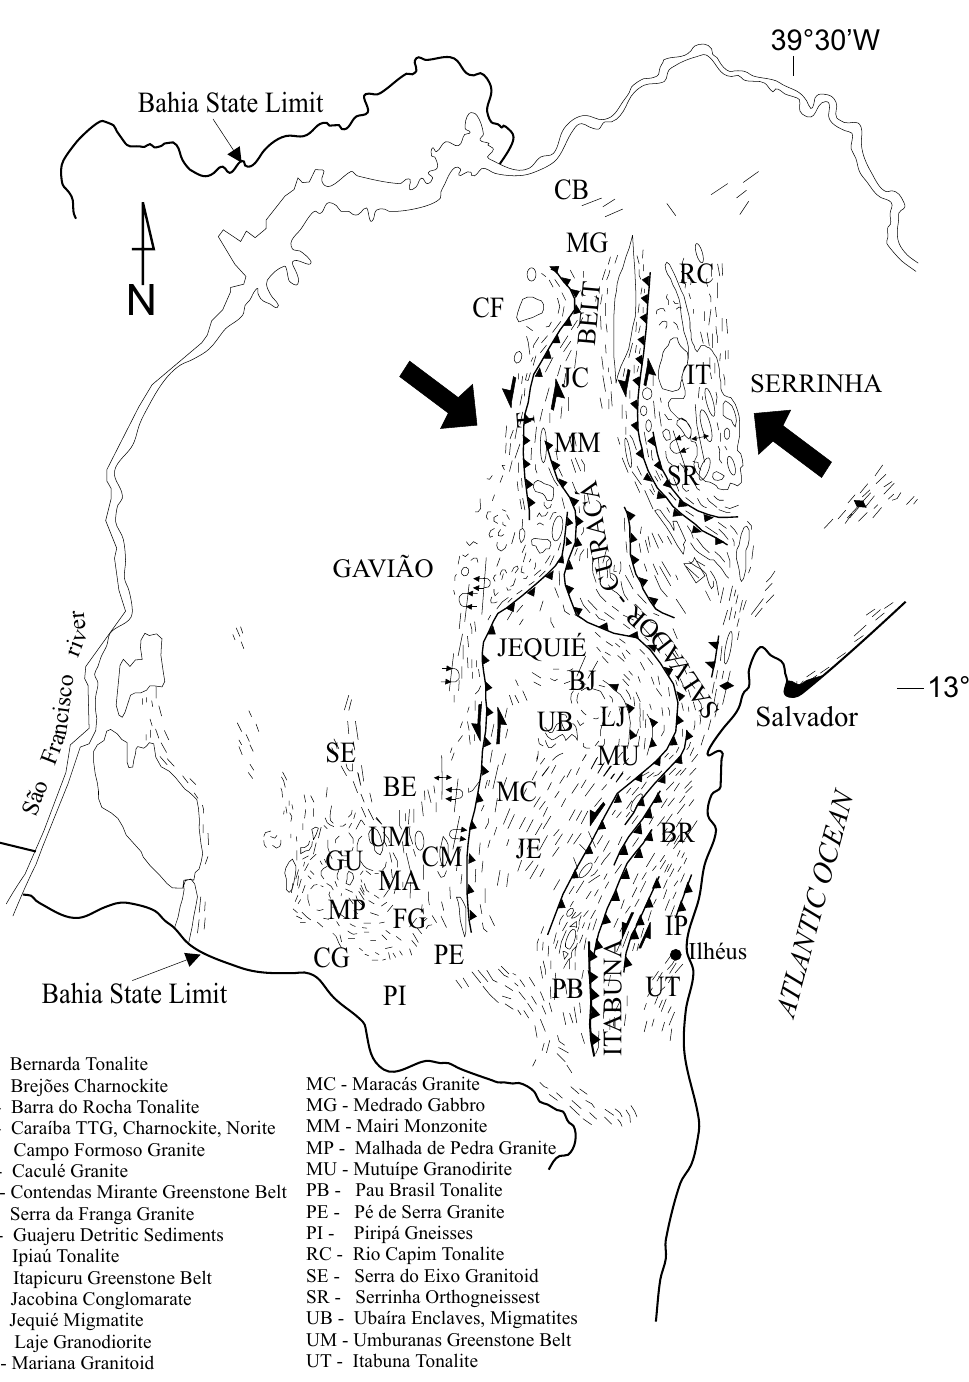
Fig. 5 – Display of theArchean blocks after the Transamazonian collision. The structural data show a global sinistral sense movement. Also show are the locations of radiometric age determinations listed in tables